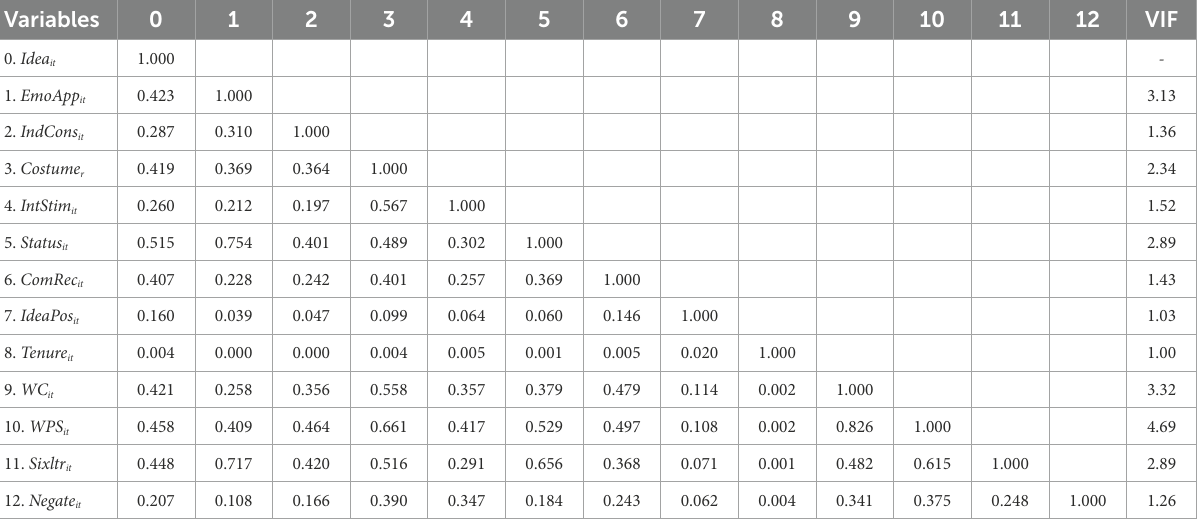
TABLE 4 Correlation